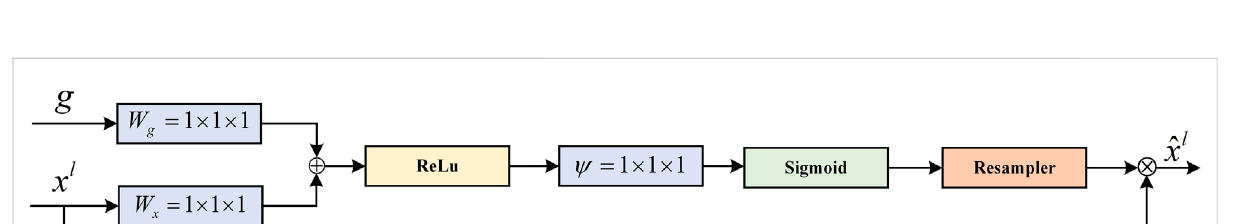
FIGURE 7 Schematic of the CA module (Hou et al., 2021).